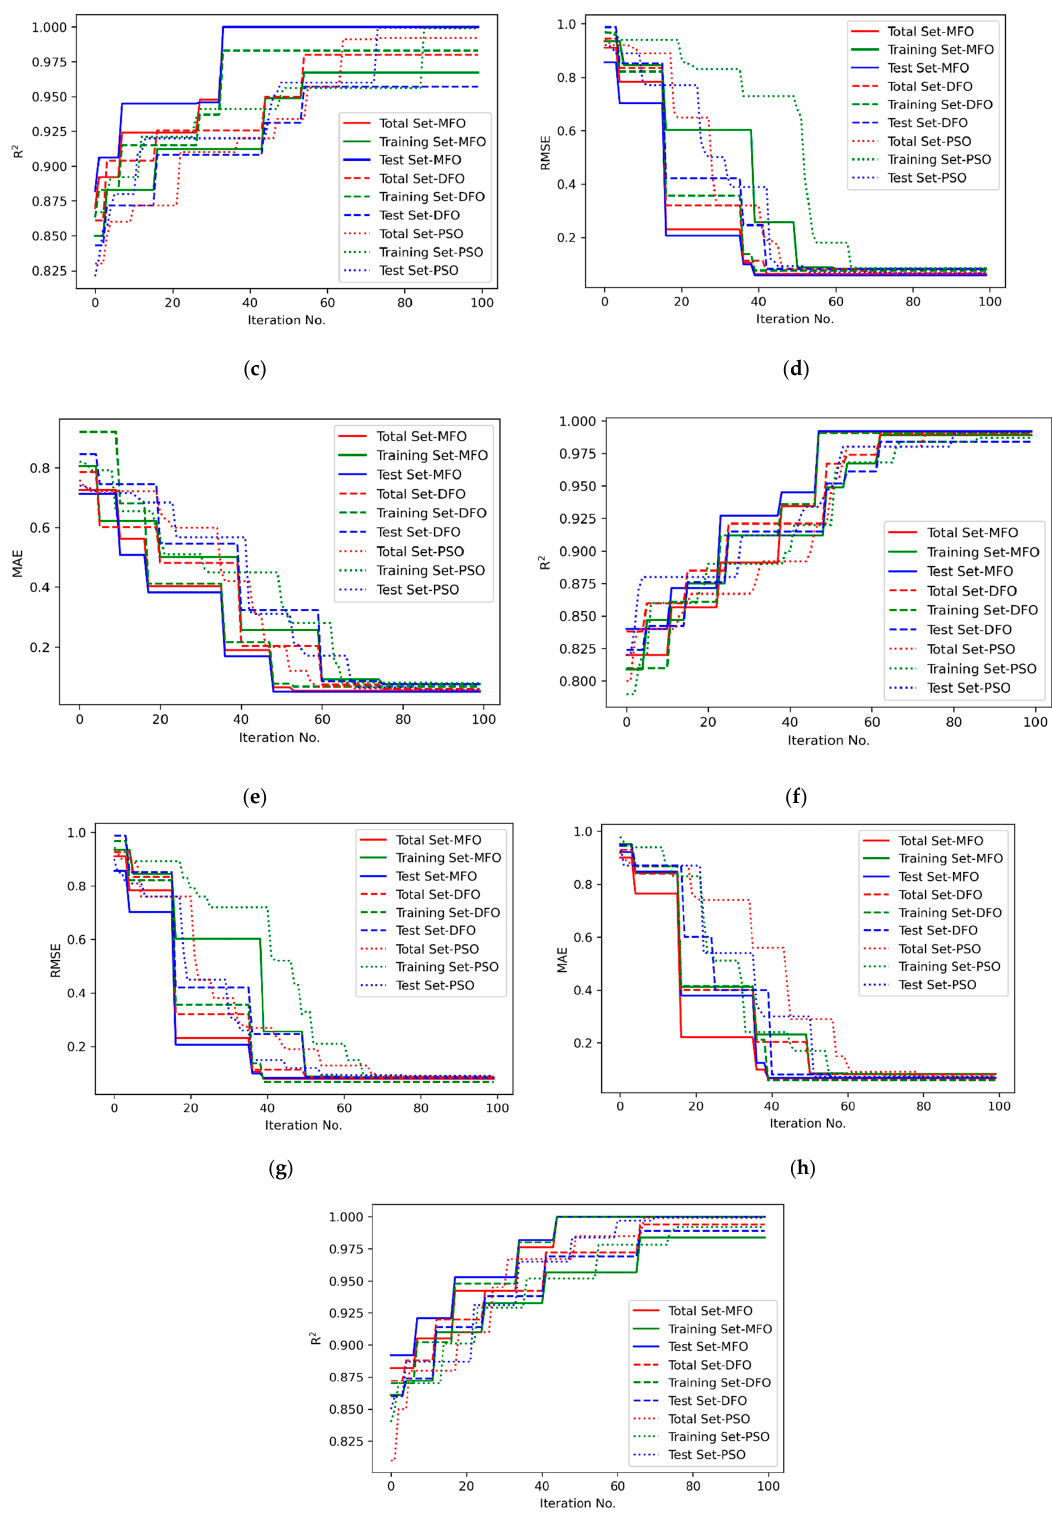
Figure 9. Convergence plot of performance of SVR for ( a ) Response L—RMSE; ( b ) Response L— MAE; ( c ) Response L—R 2 ; ( d ) Response D—RMSE; ( e ) Response D—MAE; ( f ) Response D—R 2 ; ( g ) Response W—RMSE; ( h ) Response W—MAE; ( i ) Response W—R 2 .